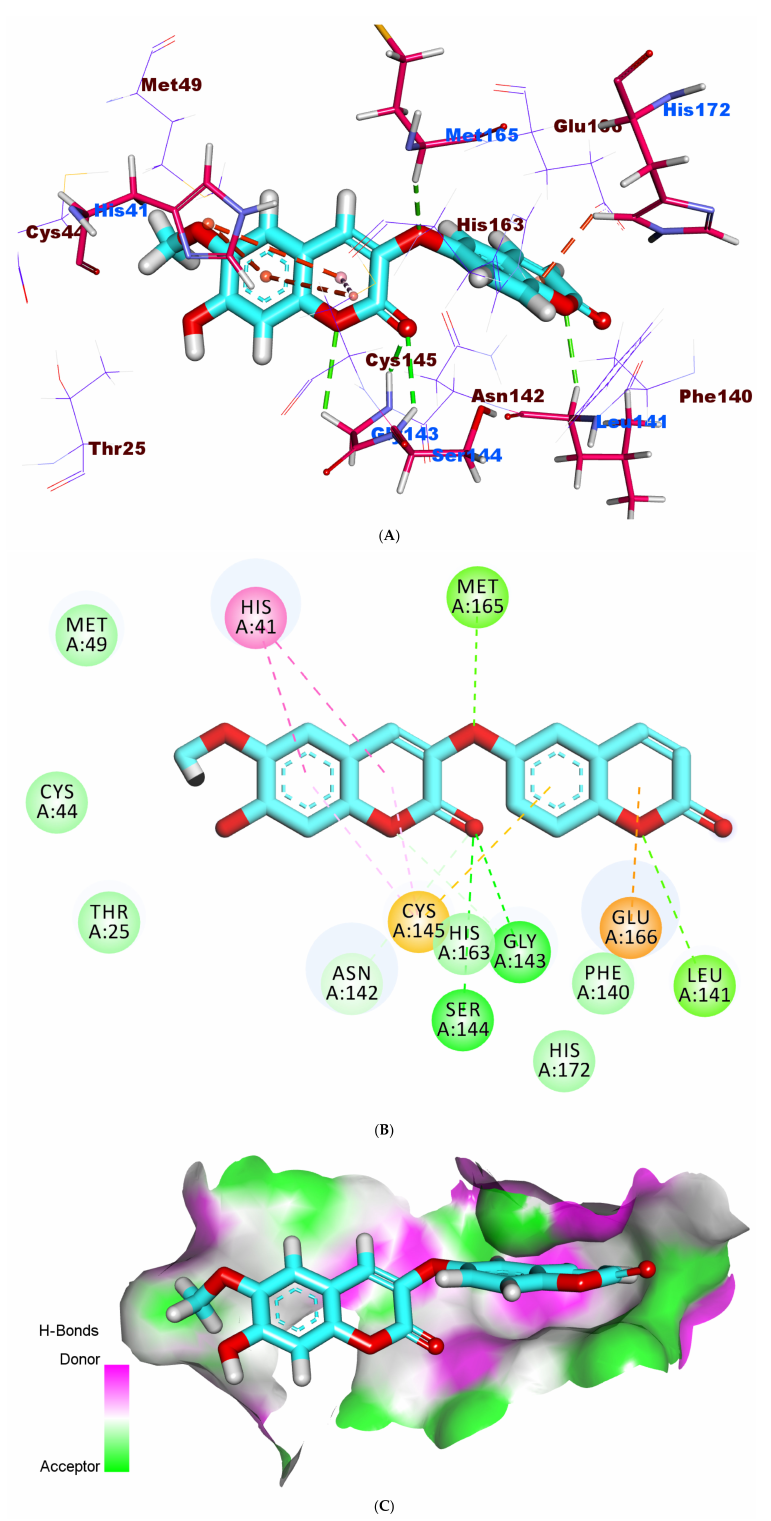
Figure 11. ( A ) 3D, ( B ) 2D, and ( C ) Surface mapping of jusan coumarin docked into the active site of M pro